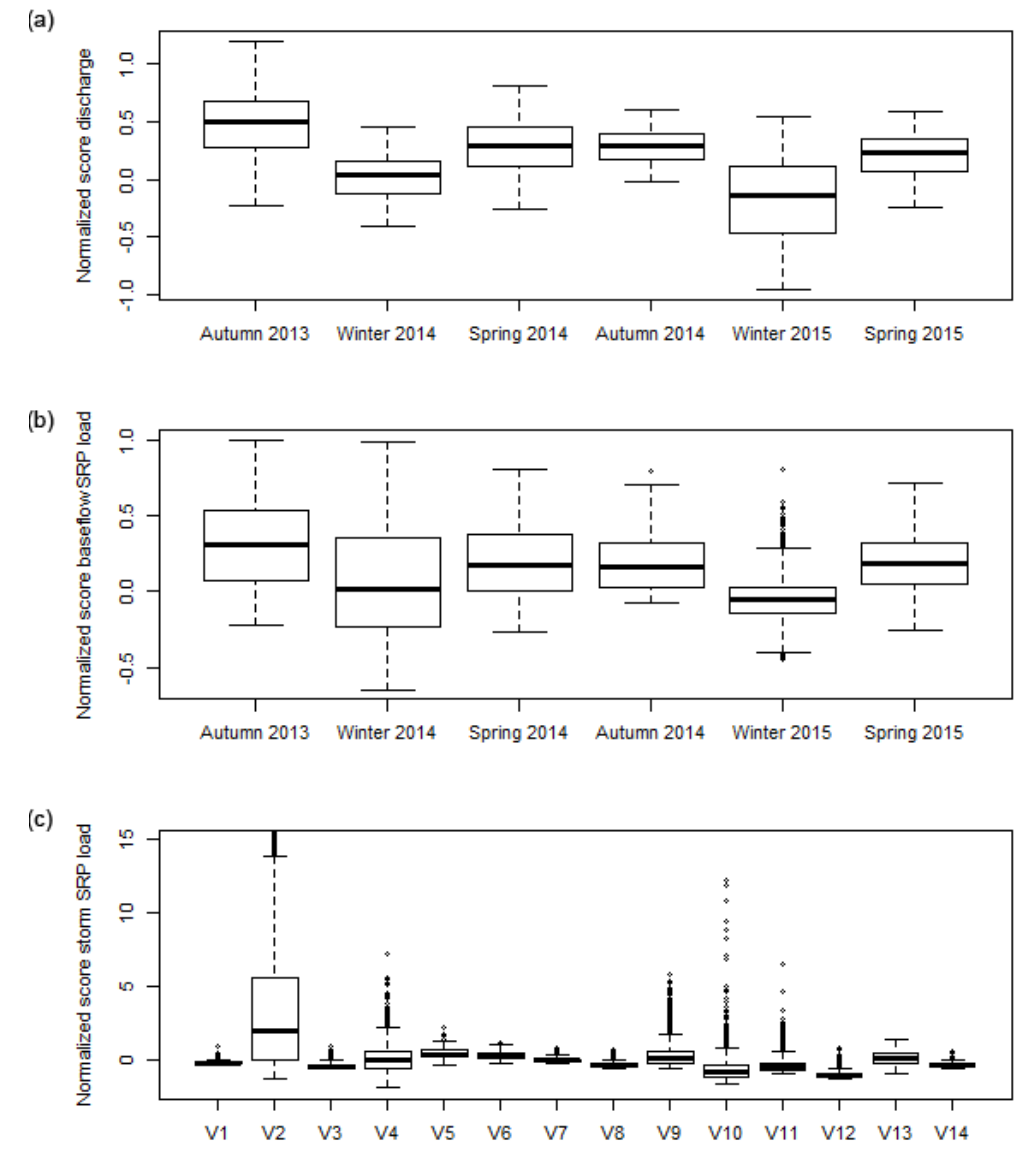
Figure 8. Normalized score for daily discharge (a) , baseflow SRP load (b) and storm SRP load (c) .